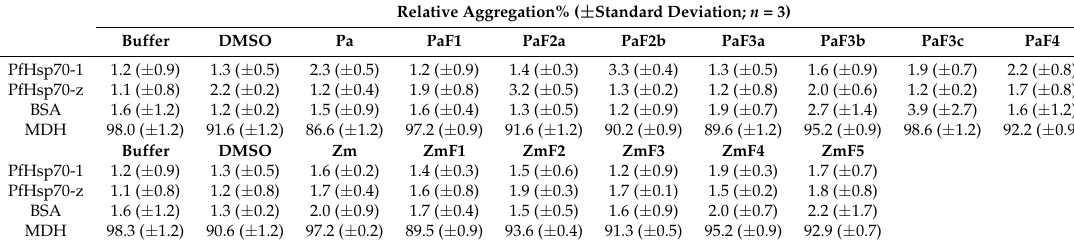
Table 2. Comparative thermal stability of PfHsp70-1, PfHsp70-z and MDH in the presence of P. angolensis and Z. mucronata